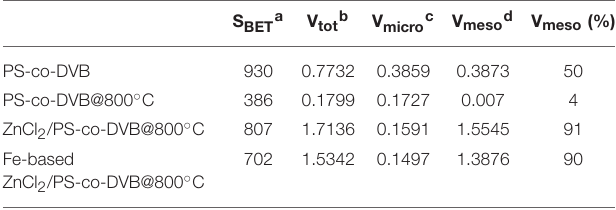
FIGURE 3 | XRD patterns of: PS-co-DVB-pyrolyzed at 800 ◦ C for 5h (black pattern), ZnCl 2 /PS-co-DVB composite spheres treated at 800 ◦ C (red pattern), the carbonized ZnCl 2 /PS-co-DVB spheres after impregnation with Fe (III) salt and treatment at the same conditions (800 ◦ C, 5h) (blue pattern). XRD plane positions of the (002), (100), and (101) graphite (PDF card #41-1487) and Fe 3 O 4 (PDF card #19-0629, asterisks) are reported.